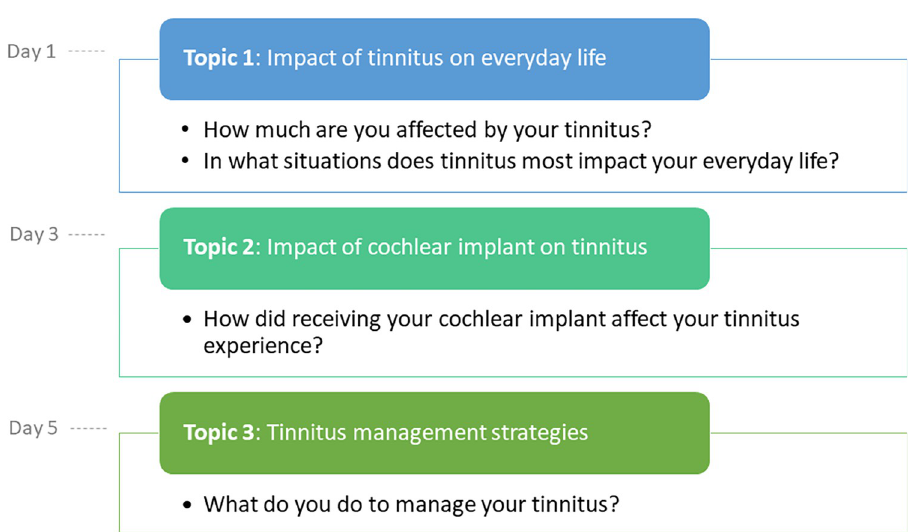
Fig 1. Design of the web-based discussion forum. The forum opened the discussion on a new topic every two days. Each topic was open for discussion until the forum closed, six days after it opened.